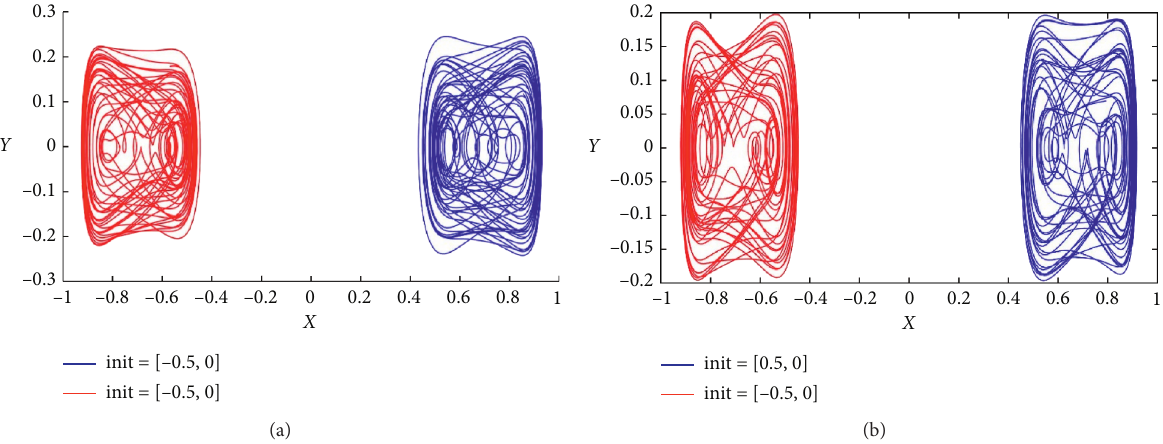
Figure 13: Phase portrait of system (7) for θ � 1 . 30 and c � 0 . 045. (a) η � 0 . 01; (b) η � 0 . 1. Remaining parameters are kept as in (9).